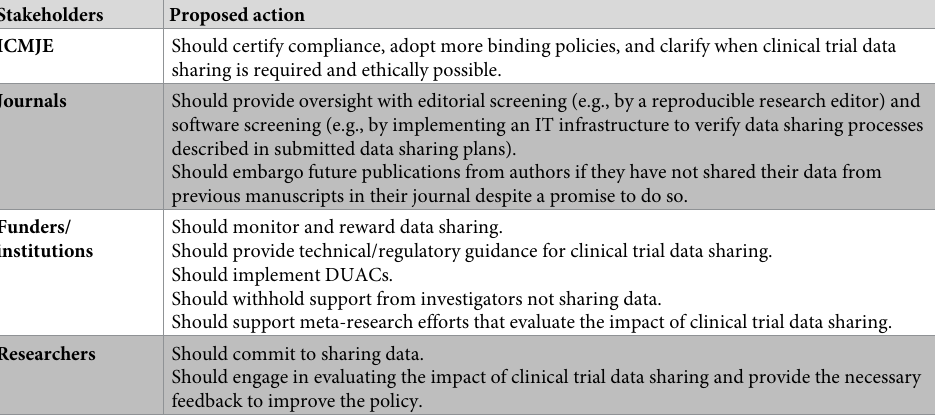
Table 2. Proposed actions for various stakeholders to ensure that the ICMJE policy meets the